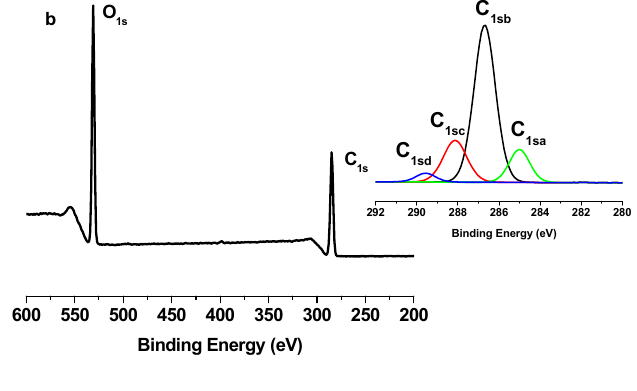
Figure 6. X-ray photoelectron spectroscopy (XPS) spectrum of TONC-g-PCL via esterification method and deconvolution of its C 1s